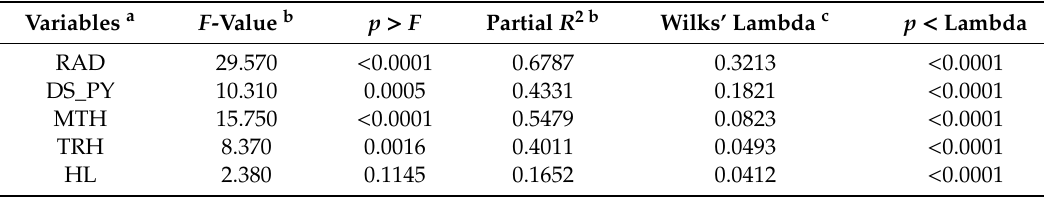
Figure 5. Discriminant analysis results presented graphically in biplots of the second linear discriminant variable (LD2) against the first (LD1). The blue, green and turquoise points represent the years correctly classified in periods I, II and III, respectively. The red points indicate the years that are misclassified. ( A ) All the weather-related variables are used, and the overall correct classification rate is 70.6%. ( B ) The discriminating subset of five variables (MTH, DS_PY, HL, TRH, RAD) found to be sufficient at the end of the stepwise procedure is used: 93.5% of the years are correctly classified within the three ODM periods. Table 5. Weather-related variables retained in the stepwise discriminant analysis procedure, applied to identify the smallest su ffi cient set of discriminating variables for periods I, II and III, and the corresponding